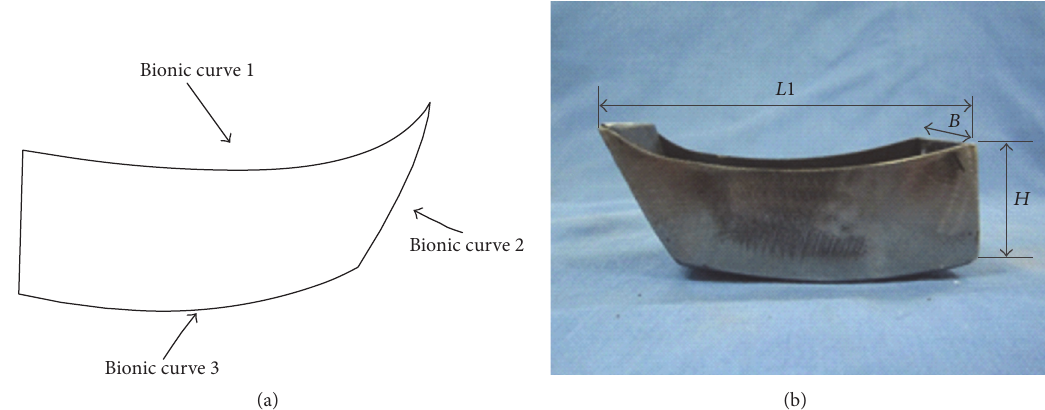
Figure 11: (a) Schematic diagram of the bionic sampling shovel. (b) The completed sampling shovel ( 𝐿1 = 88.93, 𝐵 = 45, and 𝐻 = 30).